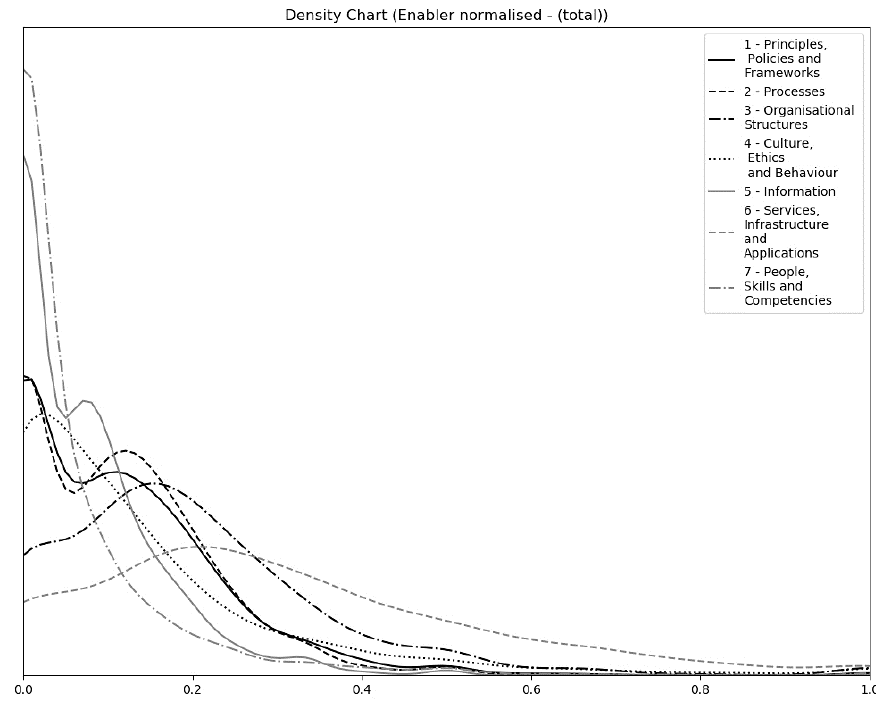
Figure 3. Density chart for all candidates with all COBIT